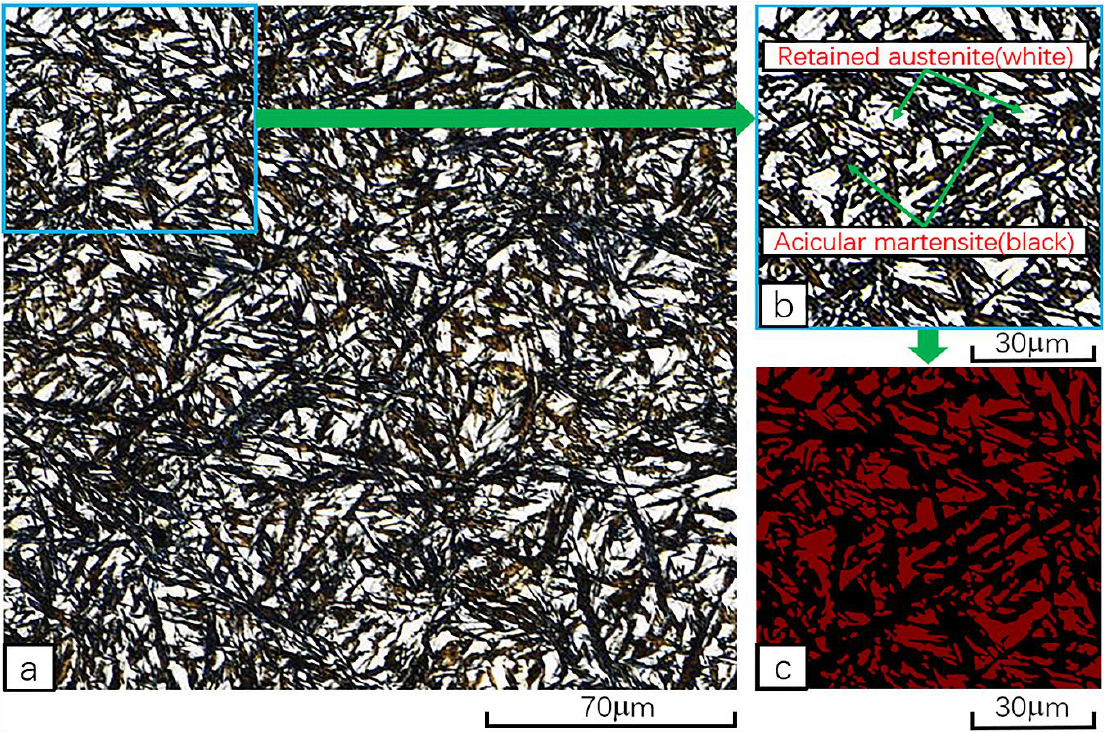
Figure 6. Splitting method when inputting microstructure images into SegModel-MOS, ( a ) Original Picture; ( b ) Crop picture; ( c ) segmentation Picture.